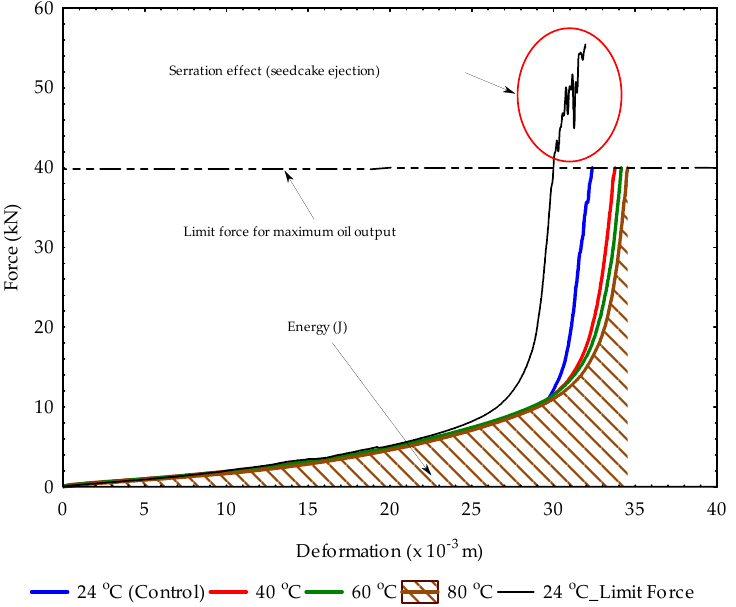
Figure 2. Force and deformation curves of hulled sunflower seeds samples’ oil extraction at differ- ent heating temperatures showing the maximum limit force and the serration effect. heating temperatures showing the maximum limit force and the serration